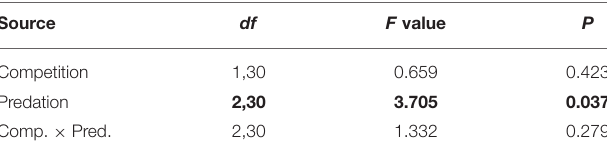
TABLE 5 | ANOVA results for number of blood feeding bouts required for female Aedes aegypti to successfully take a blood meal. Source df F value P Competition 1,30 Predation 2,30